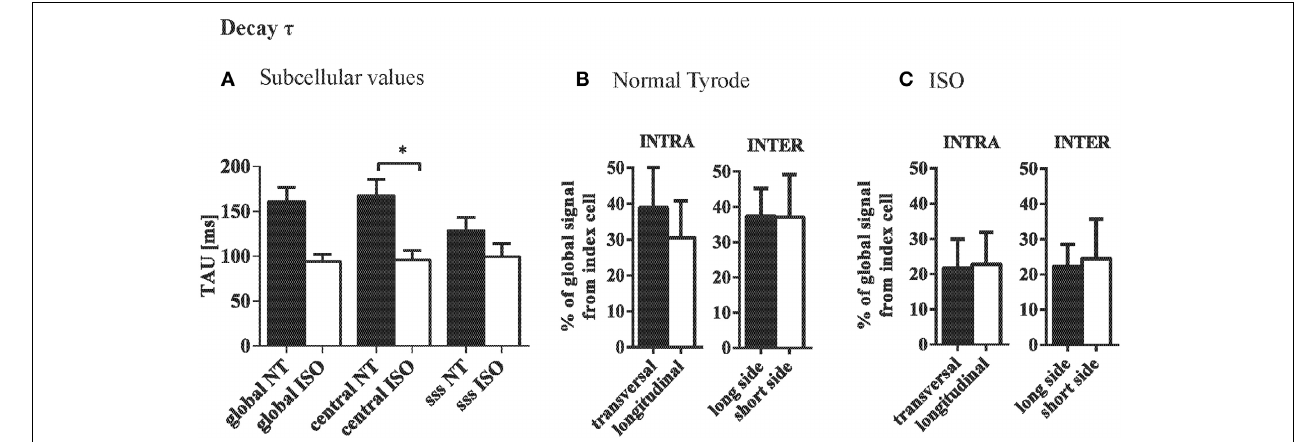
FIGURE 6 | Ca removal is synchronous at steady state stimulation. (A) Decay of the CaT (tau) was not systematically different between central and subsarcolemmal (SSS) regions within cardiac myocytes. (B) Variation in tau